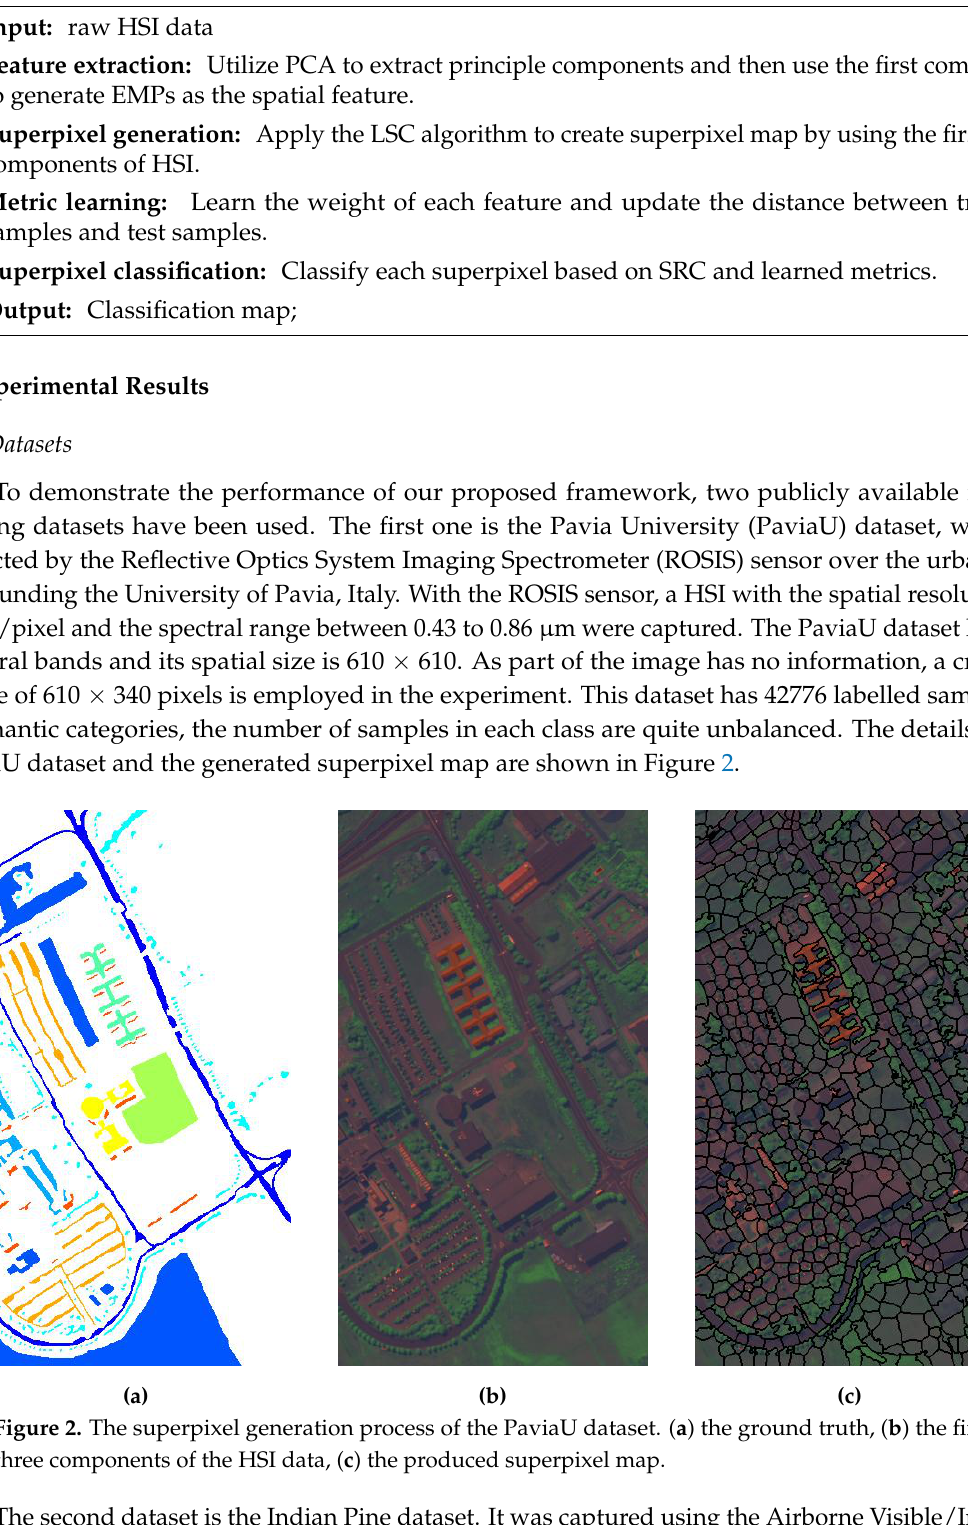
Algorithm 2 SPFS-SRC.